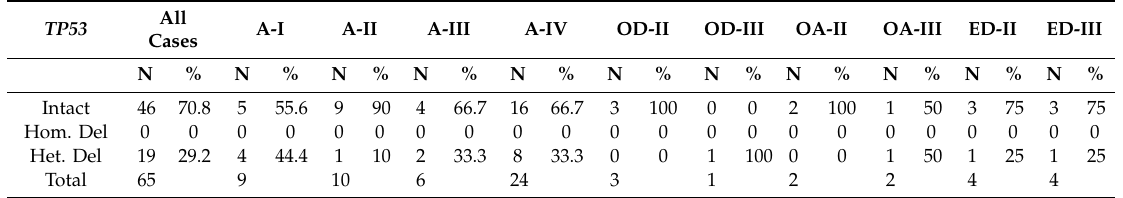
Table 3. Frequency of TP53 deletion in each histologic and WHO grading group.